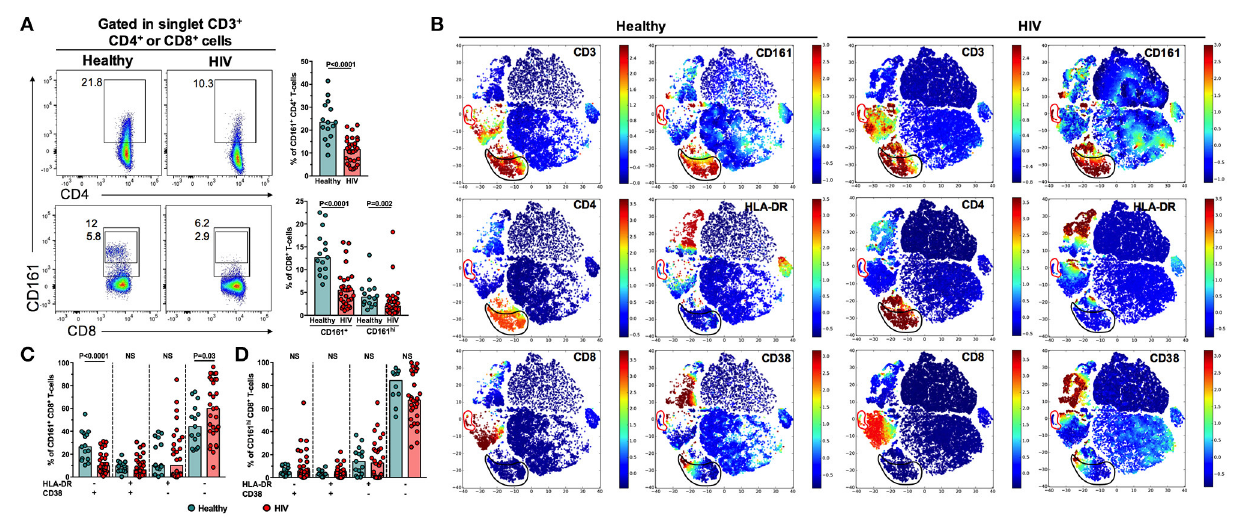
FIGURE 1 | Low frequency of circulating non-activated CD161-expressing CD8 + T-cells in PLWH. (A) Gating strategy for the detection of circulating CD161-expressing CD4 + and CD8 + T-cells. Representative pseudocolor plots from a healthy individual and a subject living with HIV are shown. Peripheral blood lymphocytes were first gated and duplicates were excluded (FSC-A/FSC-H). T-cells were identified as CD3 + . The numbers next to the gates indicate the percentage of the respective population. At the right of each plot is shown the summary of the frequency of CD161-expressing CD4 + and CD8 + T-cells in healthy individuals and PLWH. (B) Cell ACCENSE t-SNE plots of CD3, CD4, CD8, CD161, HLA-DR, and CD38 expression in cells from a representative healthy individual and a subject living with HIV ( M = 30,000). The black and red circles indicate, respectively, CD161-positive CD4 + and CD8 + T-cells. (C,D) Frequency of HLA-DR- and/or CD38-expressing CD161 + (C) and CD161 hi (D) CD8 + T-cells in healthy individuals and PLWH. In (A,C,D) the P -value of the Mann-Whitney test is shown. NS, Not statistically